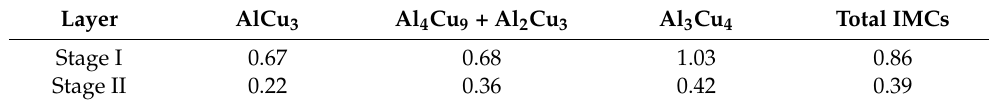
Table 2. The n values for IMCs layers at different